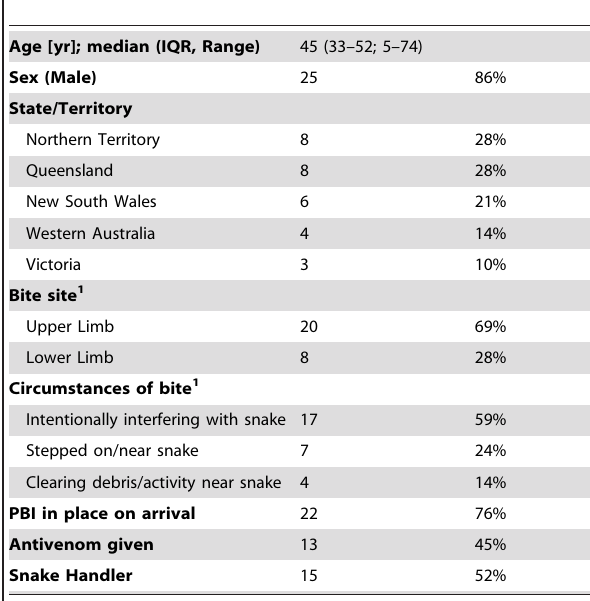
Table 1. Characteristics and demographic features of 29 patients with definite death adder